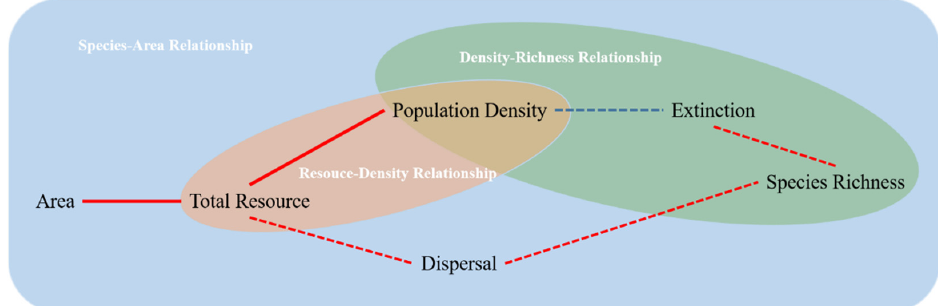
Figure 1. The research framework for this study. The red line segments in the figure indicate increases, blue lines indicate decreases, solid lines indicate proven relationships and dashed lines indicate relationships that are controversial. The blue boxed area represents the mechanism of resource-related SAR formation, the red oval area represents the mechanism for the resource–density relationship, and the green oval area represents the mechanism for the density–richness relationship. The resource hypothesis would be confirmed as one of the SAR formation mechanisms if the population density of each species increases when the total resource increases with area, which in turn leads to a lower extinction rate.